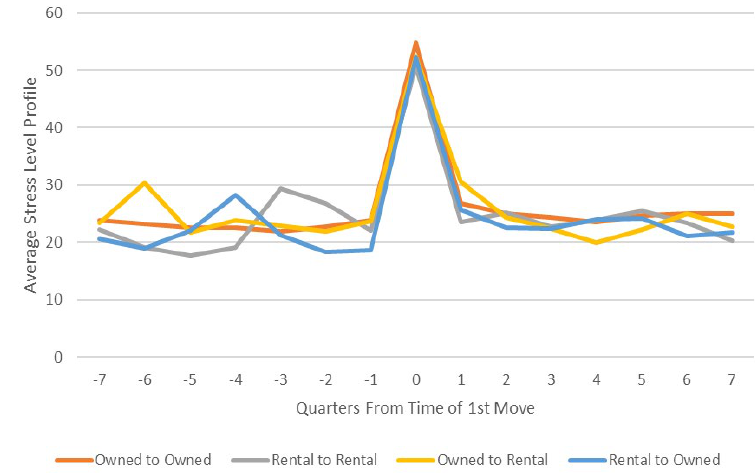
Figure 4. Average stress of one-off movers by tenure, 7-quarter before and after a move. Notes: 2-sided t -tests are conducted amongst different housing tenures before and after a home move. The mean stress level for an owner-to-owner increases from 22.96 to 24.91 (+1.95; p -value = 0.02303; with n = 1770). The mean stress level for renter-to-renter only shows an insignificant increase from 22.35 to 23.49 (+1.14; p -value = 0.3332; with n = 489). For renters who become homeowners after the home move, the stress level exhibited a significant increase in average stress level from 21.18 to 23.12 (+1.94; p -value = 0.03292; with n = 849). For the owner who becomes a renter after the move, the stress level slightly decreases from 24 to 23.92, but the change is statistically insignificant ( − 0.08; p -value = 0.4566; with n = 501).